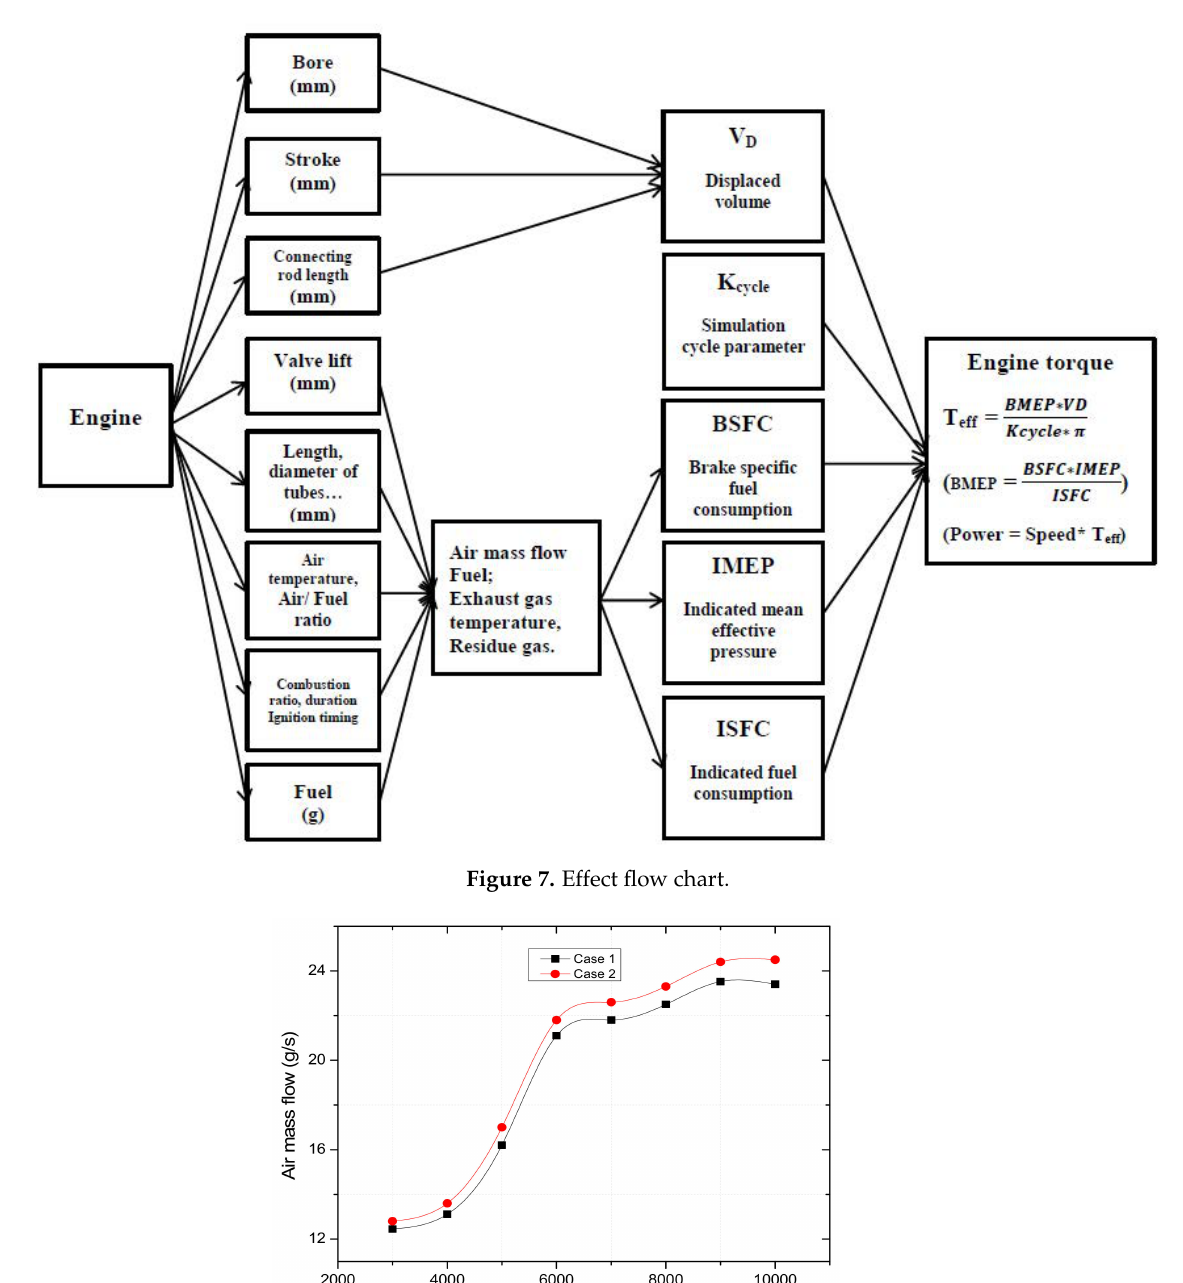
Figure 8. Comparison of air mass flow between the original and new valve mechanisms. The minimum variation in air mass flow between the two cases was 2.73% at 3000 rpm, and the maximum variation was 4.48% at 10,000